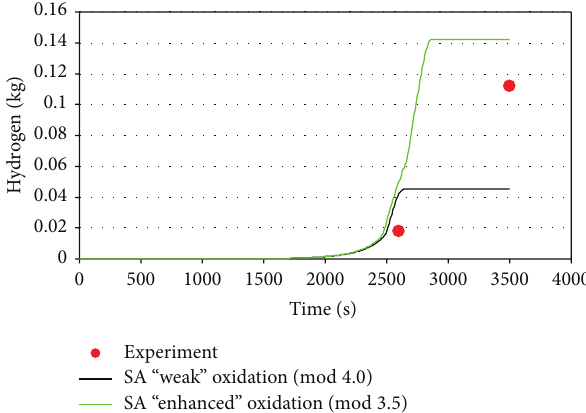
Figure 11: QUENCH-03 test calculation using RELAP/SCDAPSIM mod 4.0 and mod 3.5. The second approach of heat generation in “Cora” description. Total hydrogen mass of QUENCH-03 experi-